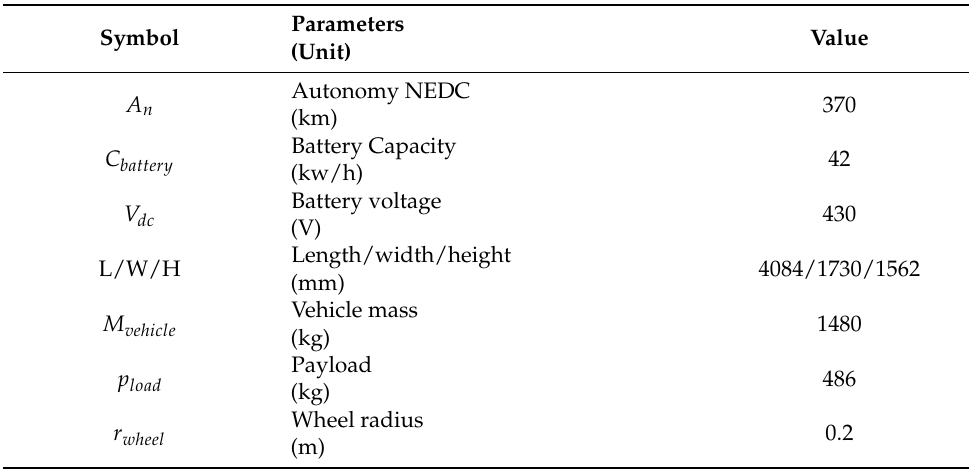
Figure 2. The power train of Renault ZOE: electrical part ( a ) and mechanical part ( b ). Table 1. Vehicle specifications.